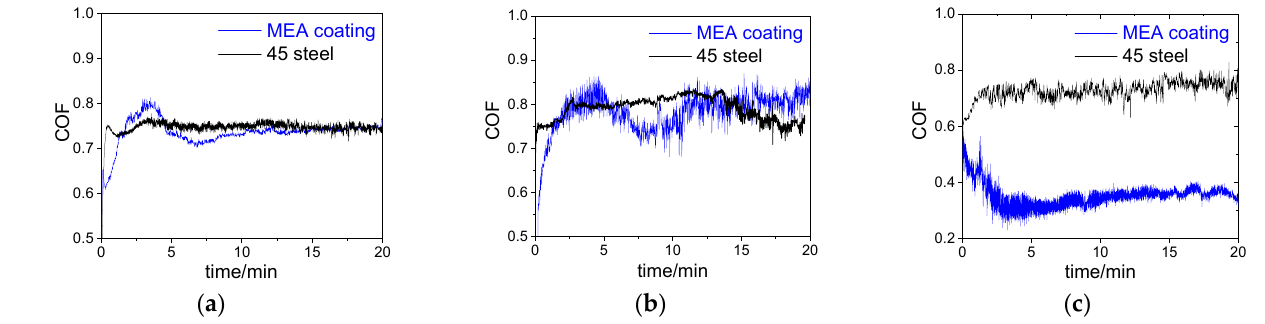
Figure 6. Friction coefficient curves at different temperatures (10 N): ( a ) 293 K; ( b ) 373 K; ( c ) 573 K.